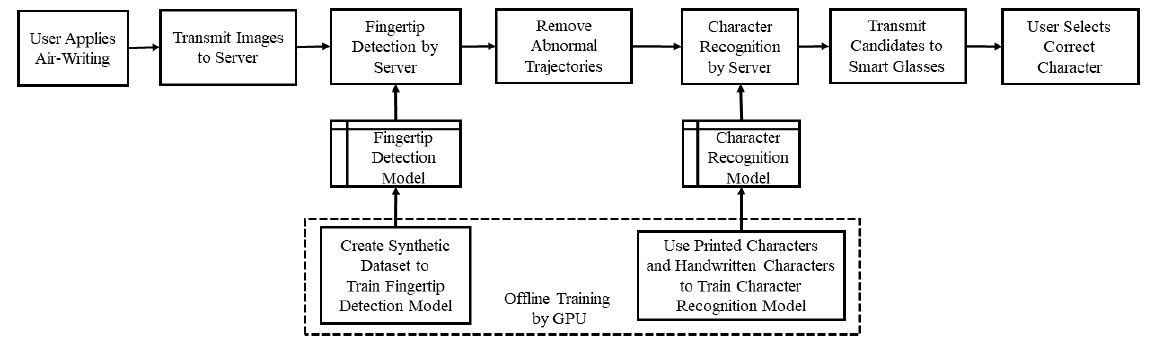
Figure 11. Diagram of proposed system